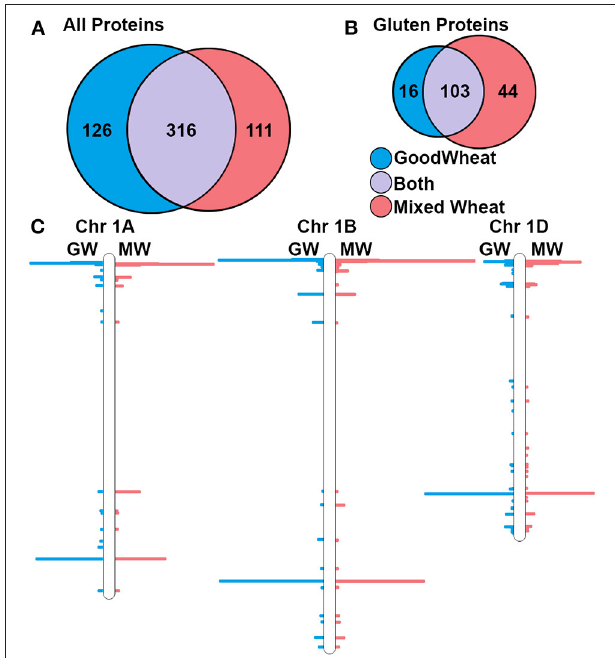
FIGURE 1 | Summary of total and gluten-like proteins identifications at 1% FDR and their corresponding chromosomal locations. (A) Venn diagram showing the total number of proteins detected within the GW and MW datasets. (B) Detected gluten proteins in MW and GW. (C) Locations of genes for detected proteins on wheat chromosomes 1A, 1B, and